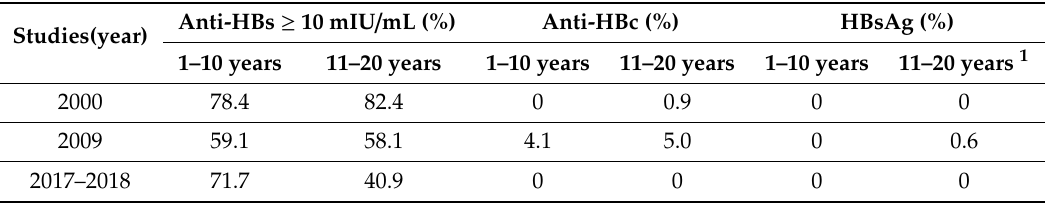
Table 5. The summary of anti-HBs ( ≥ 10 mIU / mL), anti-HBc, and HBsAg prevalence for the three seroepidemiological studies carried out in Tuscany Region (2000, 2009) and in the province of